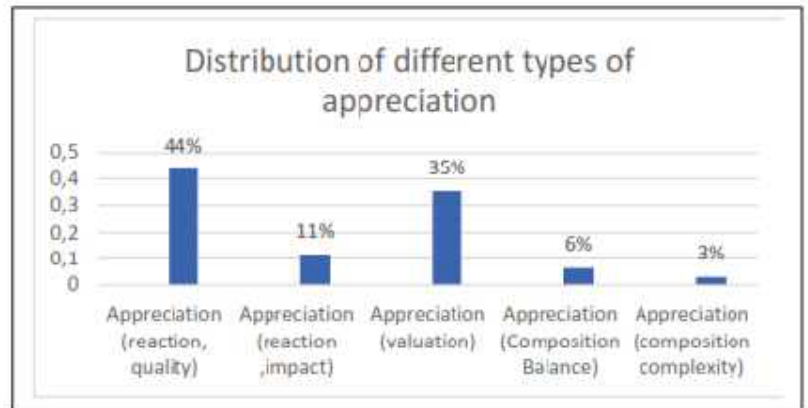
Figure 4.2 Pattern of Appreciation of Hotel Homepages in Bali and Yogyakarta Positive Reaction of